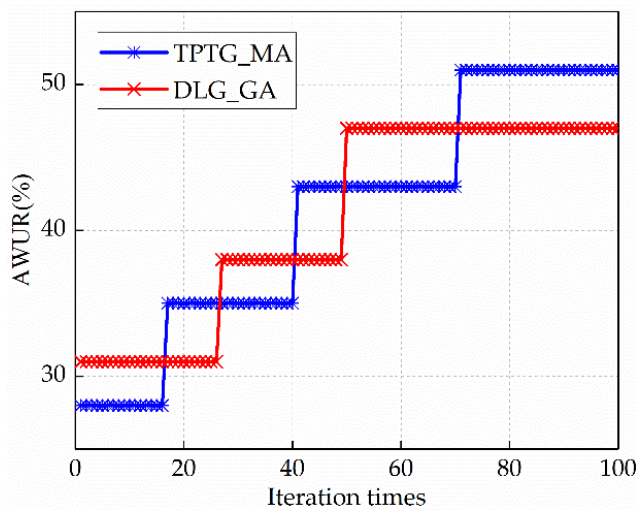
Figure 8. Comparison of convergence property between the TPTG_MA and DLG_GA.